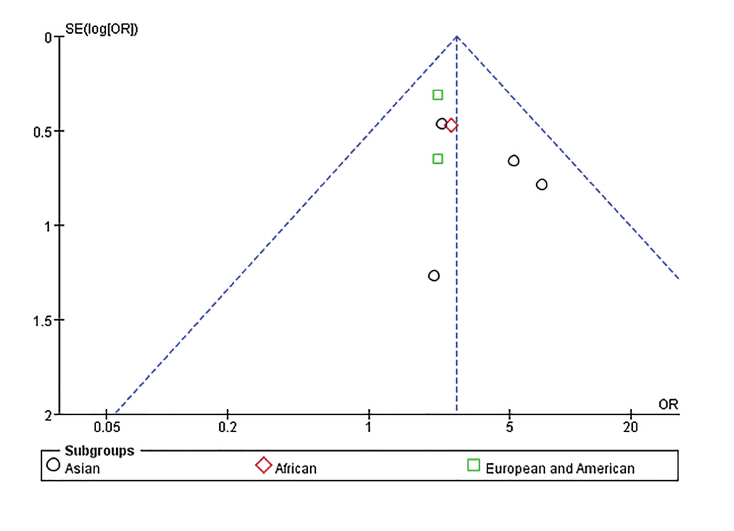
Supplementary Figure 5 - Funnel plot with stone clearance as the outcome according to geographic